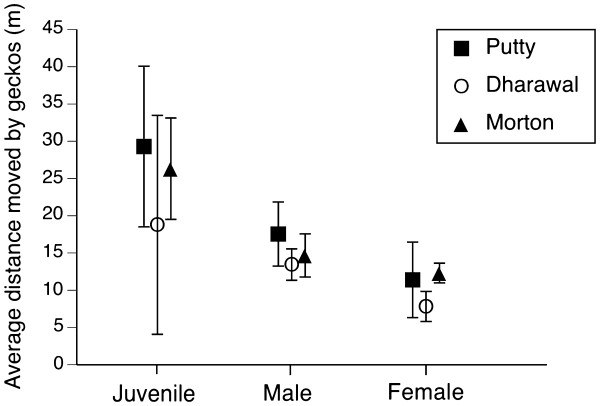
Relationship between the latitude of a site, and the nucleotide diversity of the gecko Oedura lesueurii within that site.